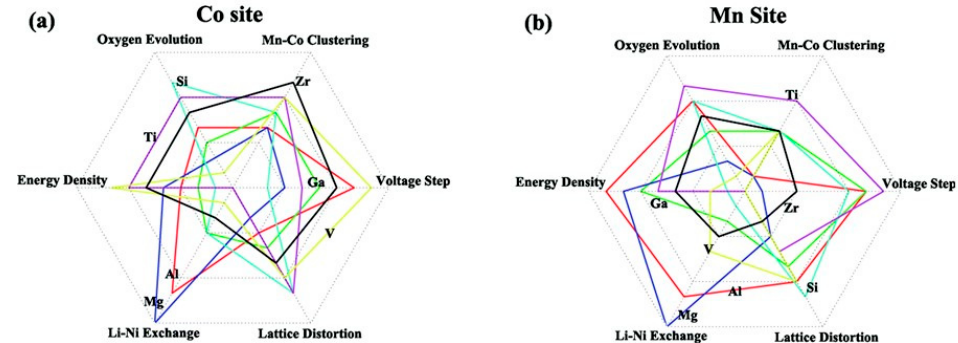
Figure 13. Spider plots of doping impact of each element (at Co and Mn sites) on different electrochemical and structural properties of NCM811. Reproduced with permission from [248]. Copyright 2017 Royal Society of Chemistry.